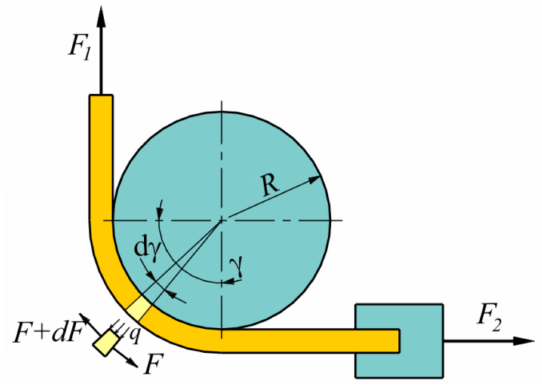
Figure 16. Forces acting on an elementary section of the